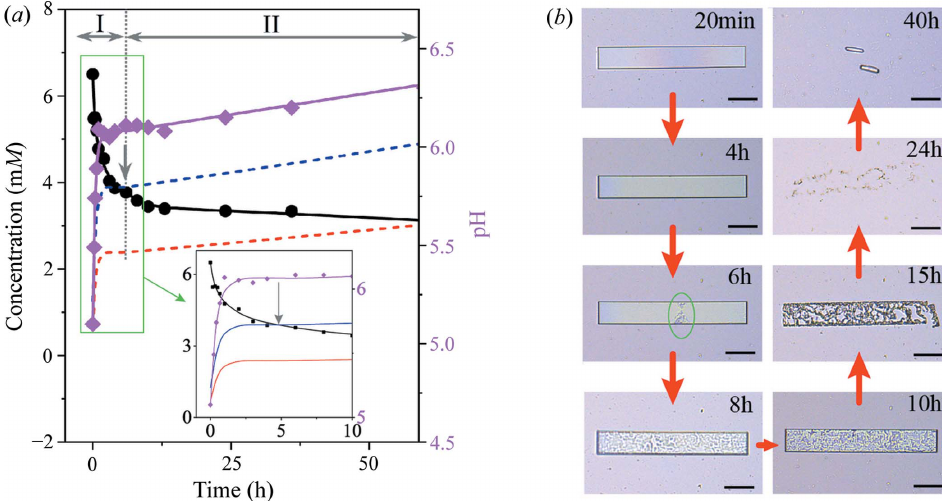
Figure 6 Crystallization kinetic profile of type-III crystals accompanied by a solvent-mediated phase transformation. ( a ) Time-resolved depletion profile of the urate concentration (black circles) and the corresponding pH (pink diamond) evolution profile in solution crystallized from a 6.5 m M urate concentration at an initial pH of 5.1. The lines are interpolated to guide the eye. I – crystallization of the UAD phase, II – solvent-mediated phase transformation from UAD to UAA. The blue- and red-dashed lines represent the solubility of UAD and UAA, respectively, measured and interpolated from experimental data (Fig. S4). The inset highlights the crystallization kinetic profile before 10 h. ( b ) Crystal morphology evolution of type-III crystals over time observed under an optical microscope. The scale bar is 50 m m.